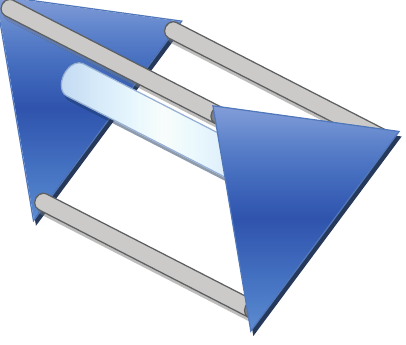
Figure 9: Top view of the actuator.